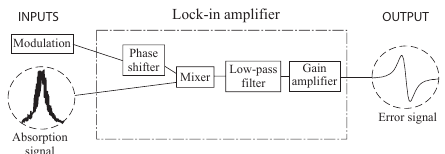
Figure 9. Schematic diagram showing the essential components of a lock-in